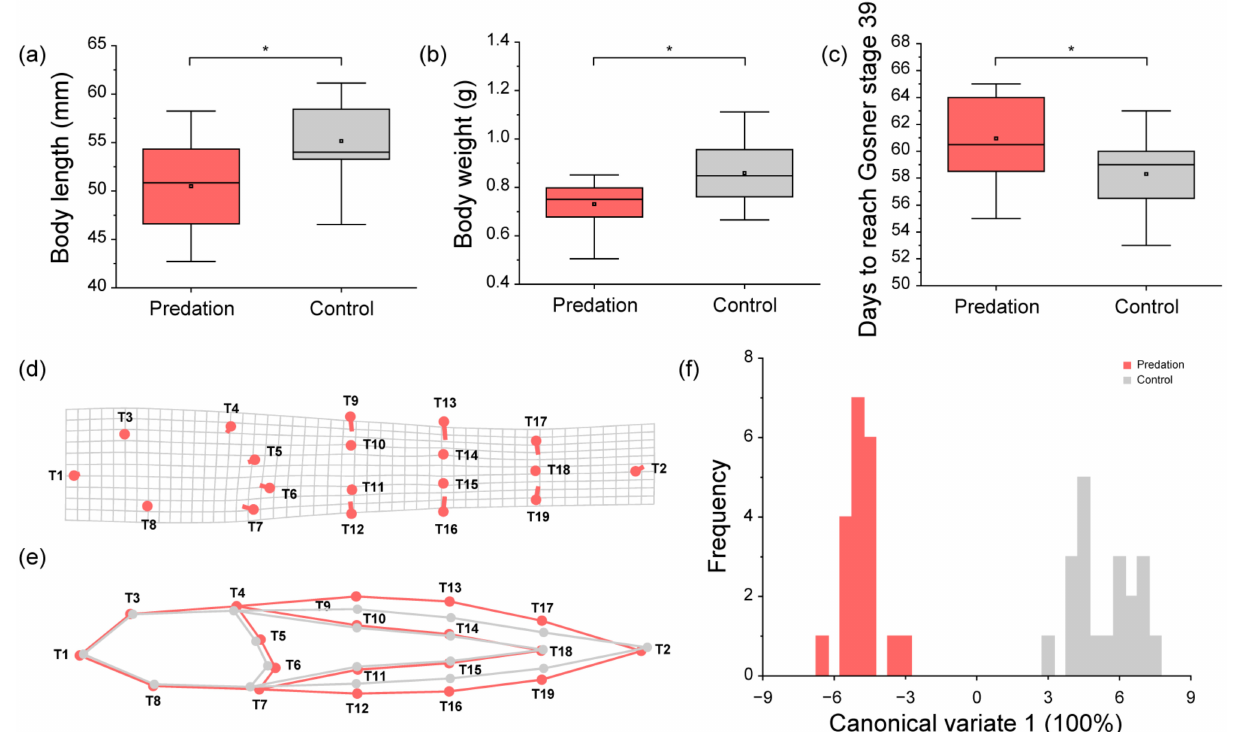
Figure 4. Comparison of the ( a ) body length; ( b ) body weight; ( c ) development rate; and ( d – f ) the body and tail shape in tadpoles (Gosner stage 39) between the predation and control groups: ( d ) The rectangular grid with landmark points and vectors of the canonical variate 1 (CV1); ( e ) the wireframe graph of the tadpole in respect to the predation and control groups from CV1; and ( f ) the distribution of the CV1 value in the tadpoles between the predation and control groups. The red and gray boxes represent the tadpoles from the predation and control groups, respectively. The box plots detail: the mean (central square dot); median (central band); 25th and 75th percentiles ( bottom and top of boxes); and range within a 1.5 interquartile (the bottom and top of the line). Significant differences ( p < 0.05) were determined using an unpaired t -test and are represented with an asterisk (*). Circles in the deformation grid, as well as the grey points and lines in the wireframe graph, indicate the body and tail shape of the individuals with the lowest CV value. The lines in the deformation grid, as well as the red points and lines in the wireframe graph, indicate the change in body and tail shape via an increase in CV